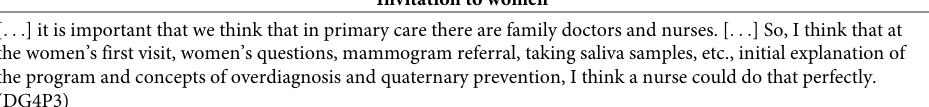
Table 6. Selected quotes from health professionals’ discussion groups on organizational proposals for a risk- based screening program. Invitation to